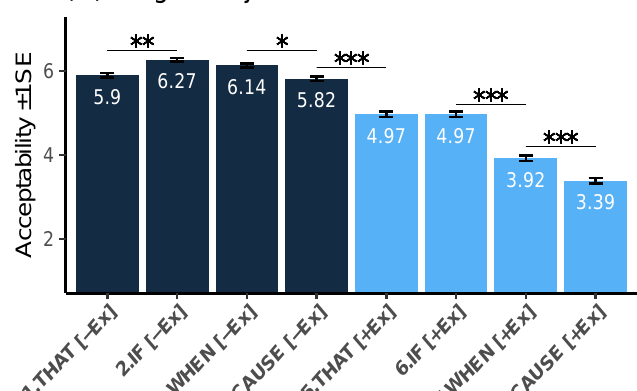
(C) Filler 2: Coordinate structure